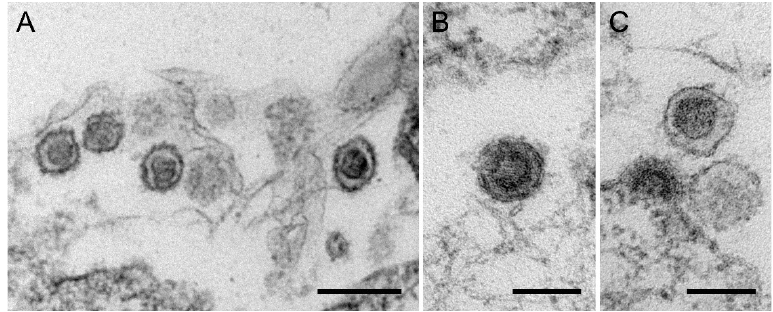
Figure 8. Electronmicroscopy of F-PERV particles produced in 293 cells. ( A ), a group of mature viruses, ( B ), a maturing virus, ( C ), a budding and a mature virus. The bar corresponds to 200 nm ( A ) and 100 nm ( B , C ).